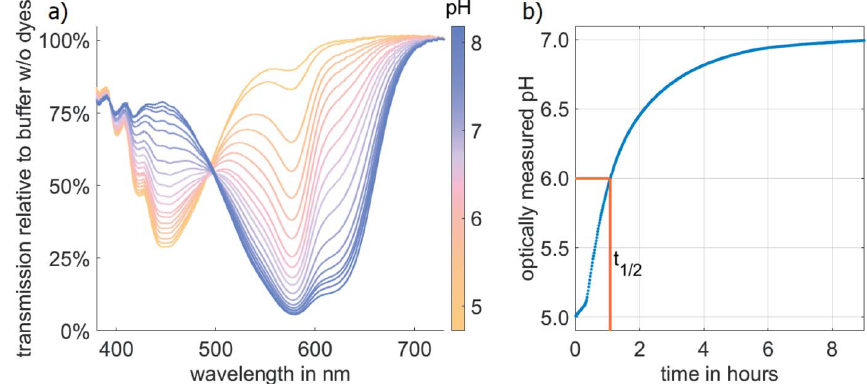
Figure 3 Time-scale of in situ pH change. ( a ) pH-dependent transmission spectra of bromothymol blue and chlorophynol red mixed at a molar ratio of 2:1. ( b ) Optical measurements of the pH inside the sample chamber during dialysis results in an approximate exchange half-life time of t 1/2 = 1